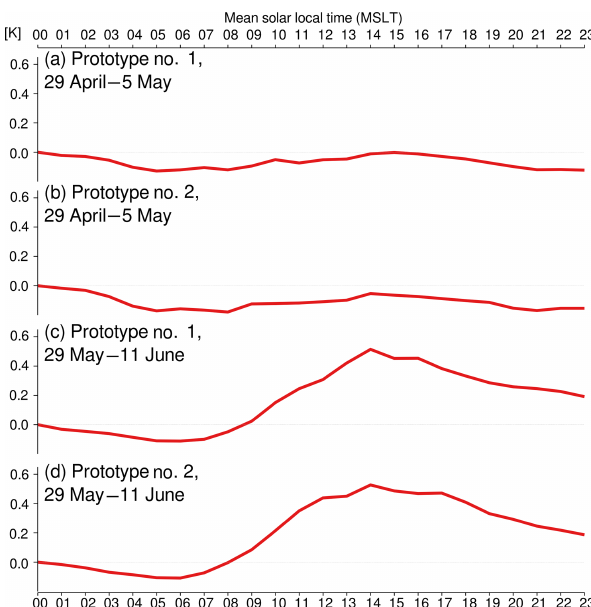
Figure 13. Diurnal cycle of differences between each 5min per- centile (five percentiles are reported by the SVP-BRST prototypes: 10%, 30%, 50% or median, 70%, and 90%), and the 5min mean. Horizontal thin dotted lines indicate zero and ± 0 .